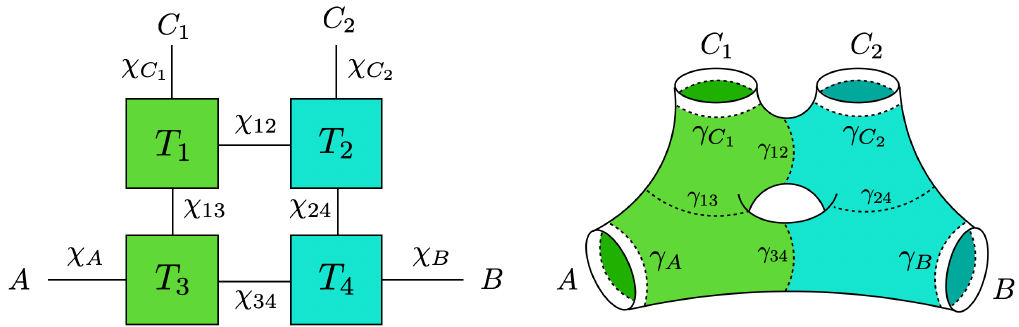
Figure 21 . (left): the 4TN network consists of four internal vertices connected by internal bonds χ ij . (right): it models a four-boundary wormhole with a